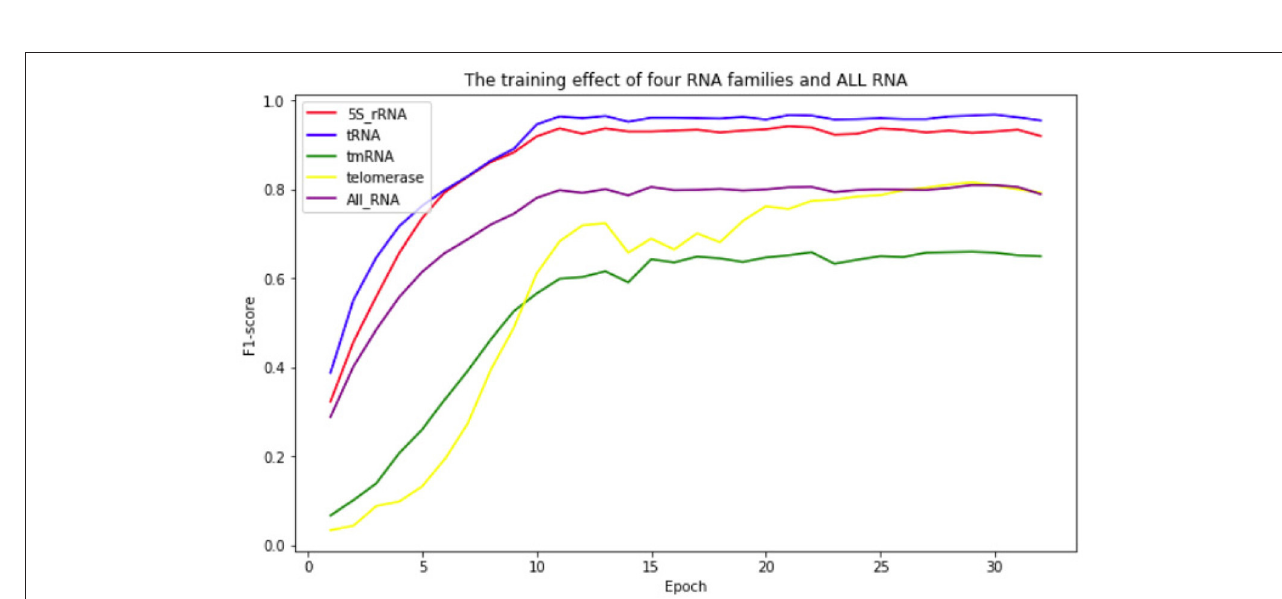
FIGURE 5 | The effect of ATTfold on the prediction of 4 RNA families and all RNA sequences.